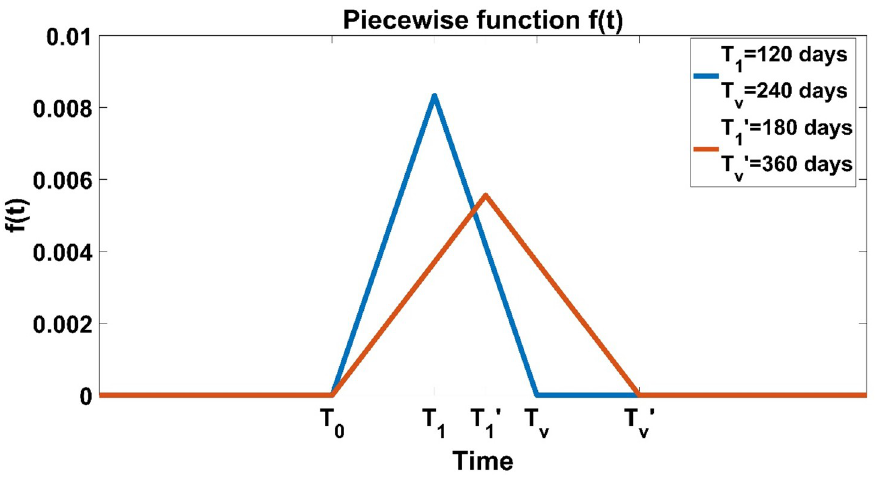
where l indicates the different locations ( l = c , h ) and k indicated the different phases, p is the proportion of the population that needs to be vaccinated, 1 efficacy and S is the susceptible population at time T T 0 Fig 2. The list of the parameters and assumptions are provided in Tables 1 and 2, respectively.